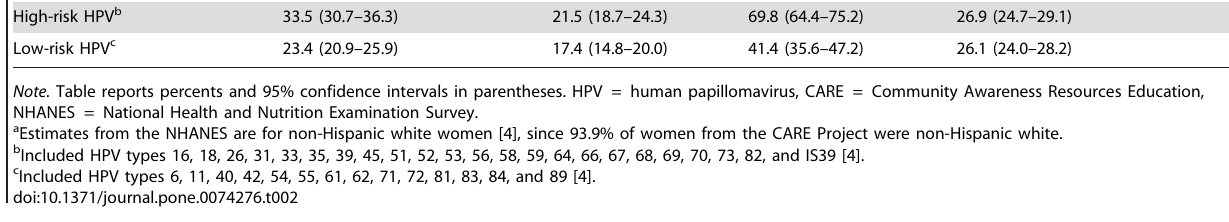
CARE – All women CARE – Controls CARE –